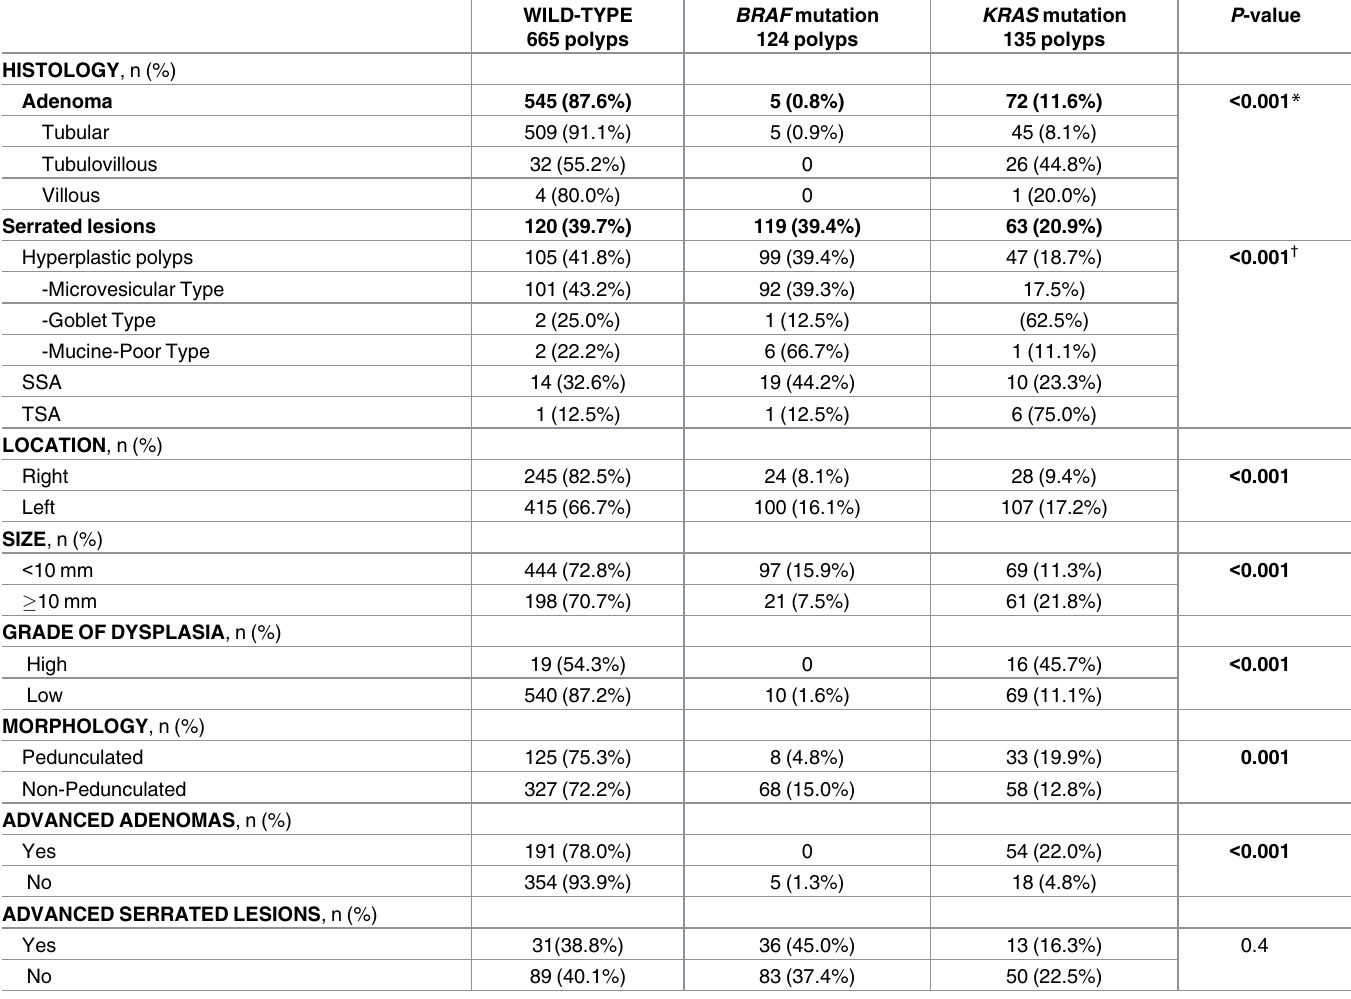
Table 1. Molecular characteristics of